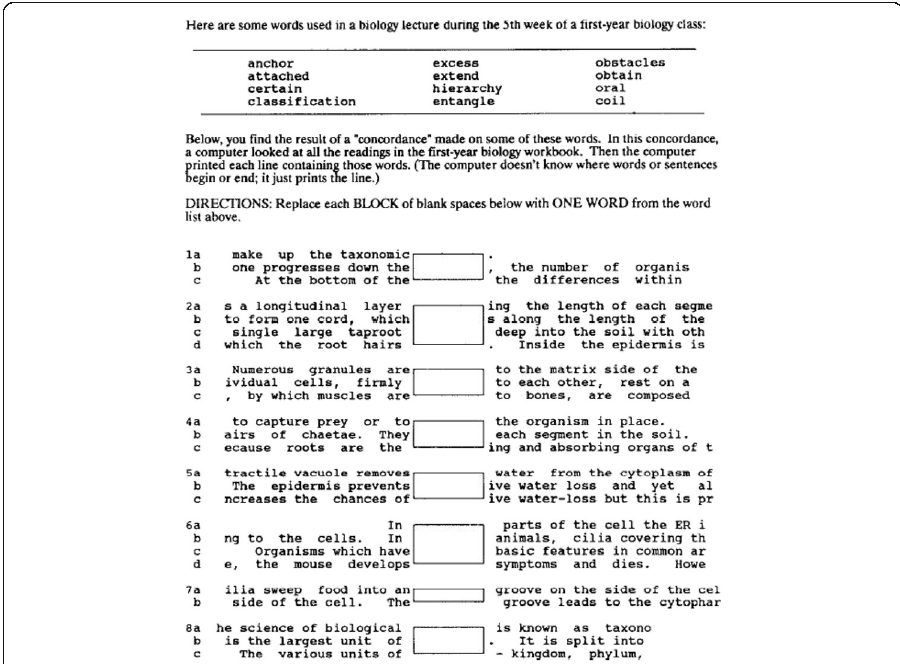
Fig. 3 Stevens ’ s (1991, p. 38) concordance-based vocabulary